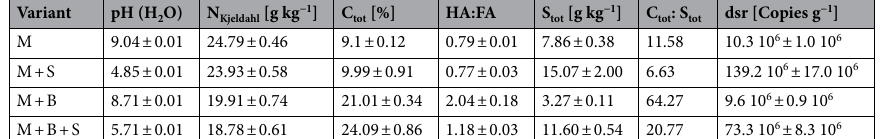
Table 3. Chemical properties of the prepared matured amendments at the end of maturation.